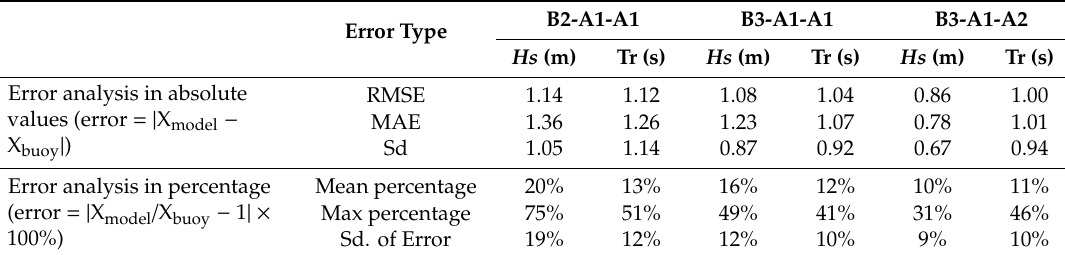
Table 3. Error analysis of the three